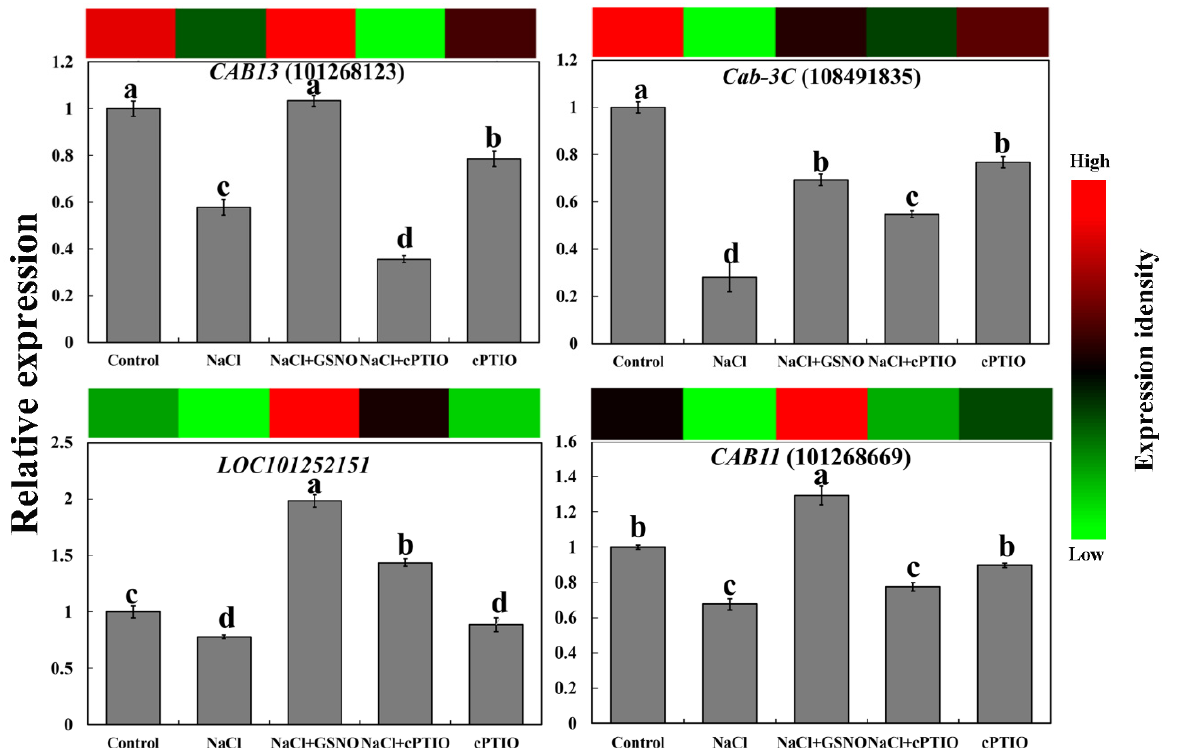
Figure 6. Quantitative real-time PCR analysis of the expression profiles of four genes related to photosynthesis during NO alleviation of salt stress. The color scale corresponds to relative expression values of genes, with red indicating upregulation and green indicating downregulation. The error line is the standard error. Different letters mean significant difference by Duncan’s multiple range test (p < 0.05).